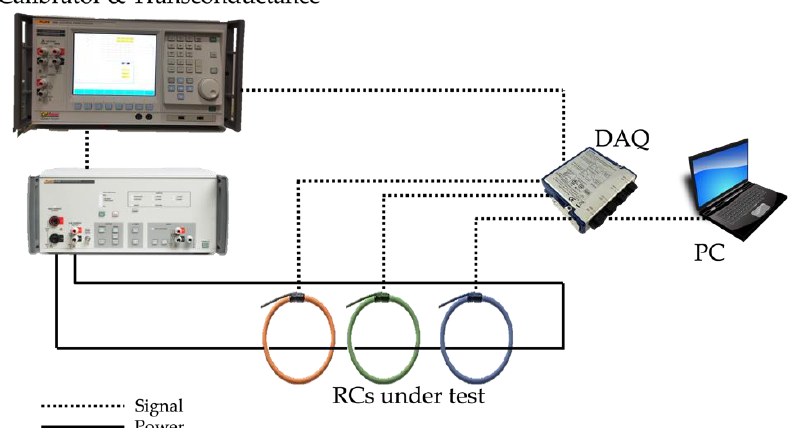
Figure 1. Schematic of the adopted measurement setup. Table 1. Main characteristics of the